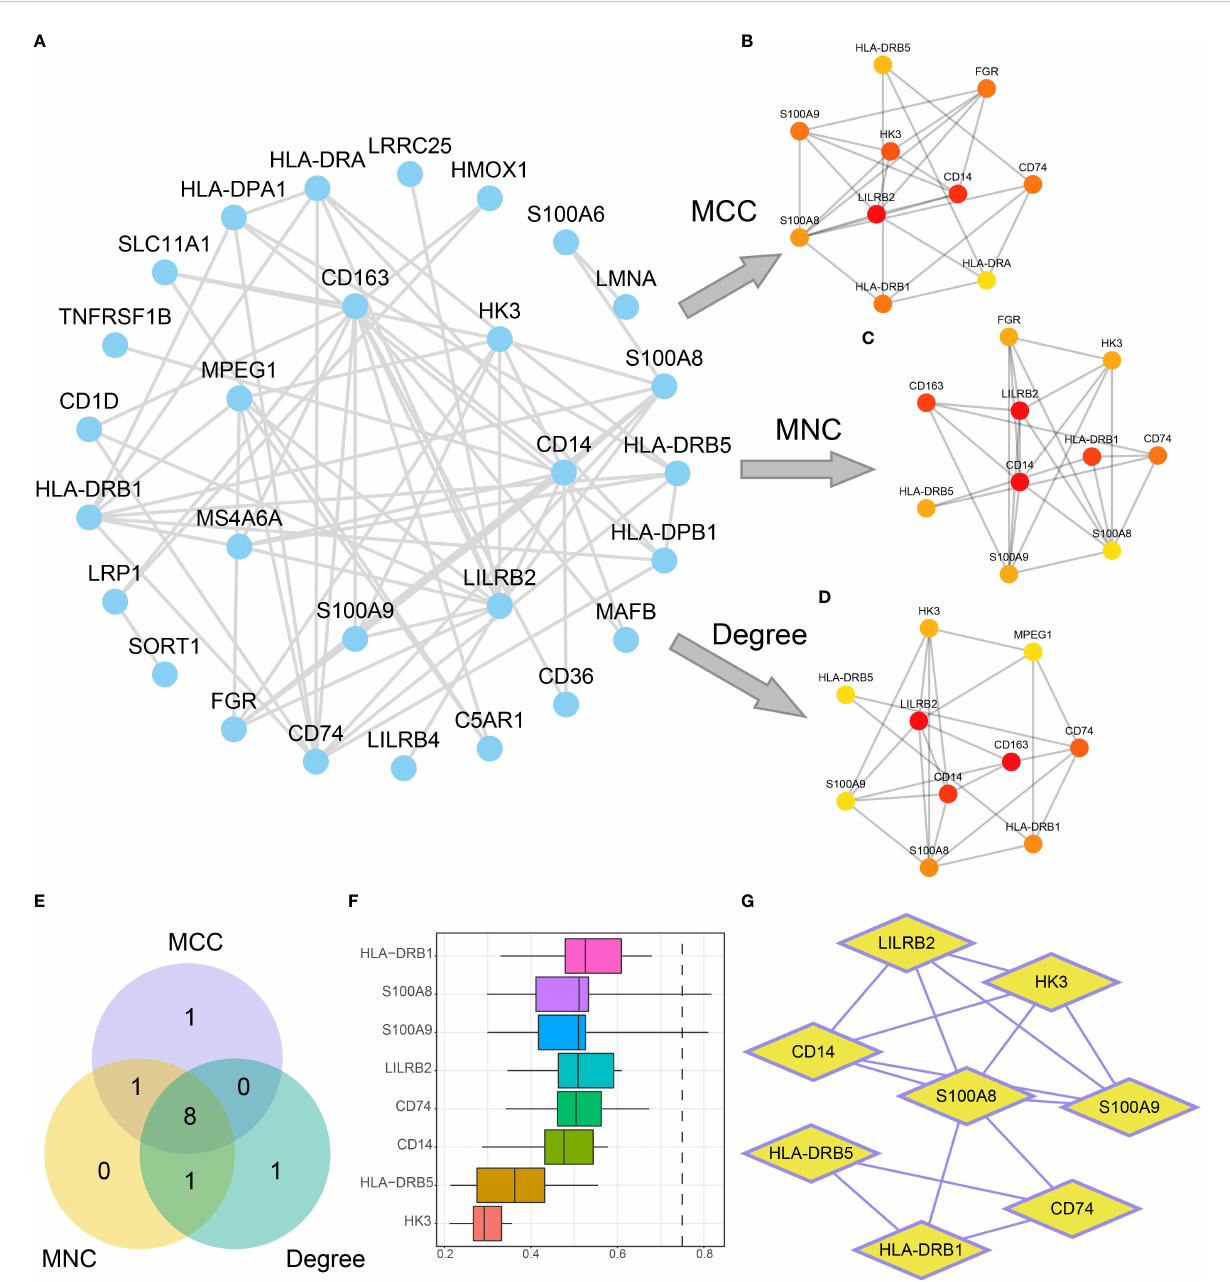
FIGURE 9 Construction of the PPI network. (A) PPI network of DEGs. (B-D) . Interaction networks of the top 10 DEGs in the PPI network obtained by the MCC (B) , MNC (C) , and Degree (D) algorithms. The color of the dots in the fi gure changes from yellow to red, indicating gradual increases in scores. (E) The Venn diagram of the top 10 DEGs obtained by the three algorithms. (F, G) . Functional similarity analysis results (F) and PPI network (G) of hub